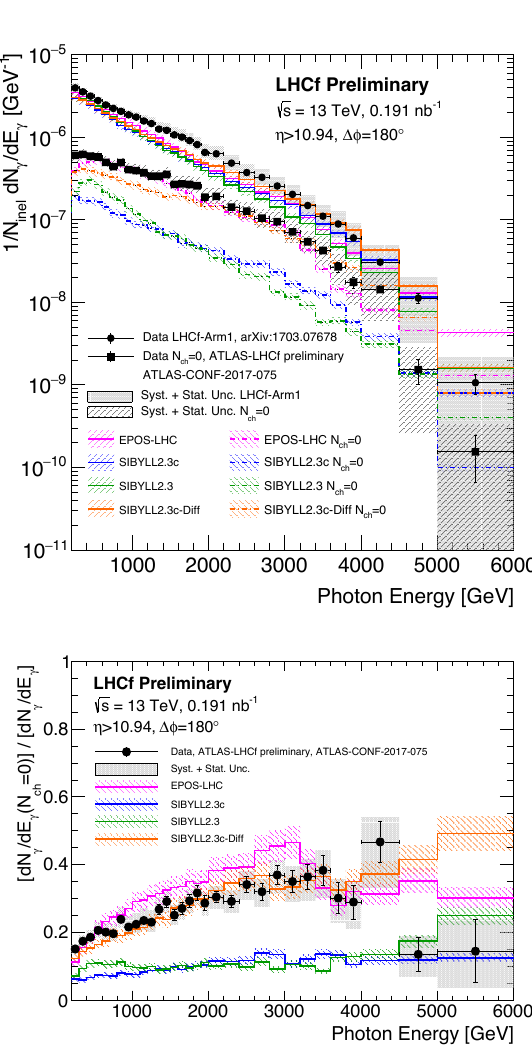
η > 10.94 (top pad). Filled circles | |